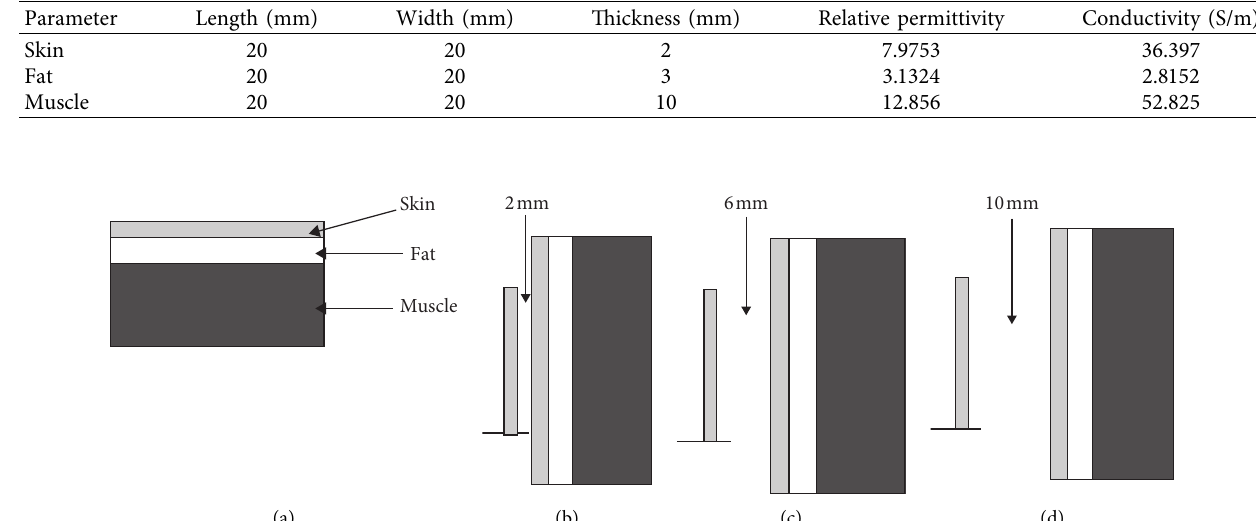
Table 8: Properties of a torso phantom.